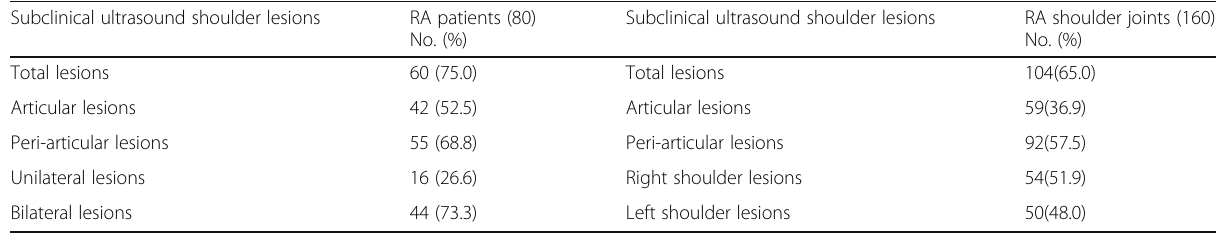
Table 2 Frequency of subclinical MSUS lesions in RA patients and their shoulder joints Subclinical ultrasound shoulder